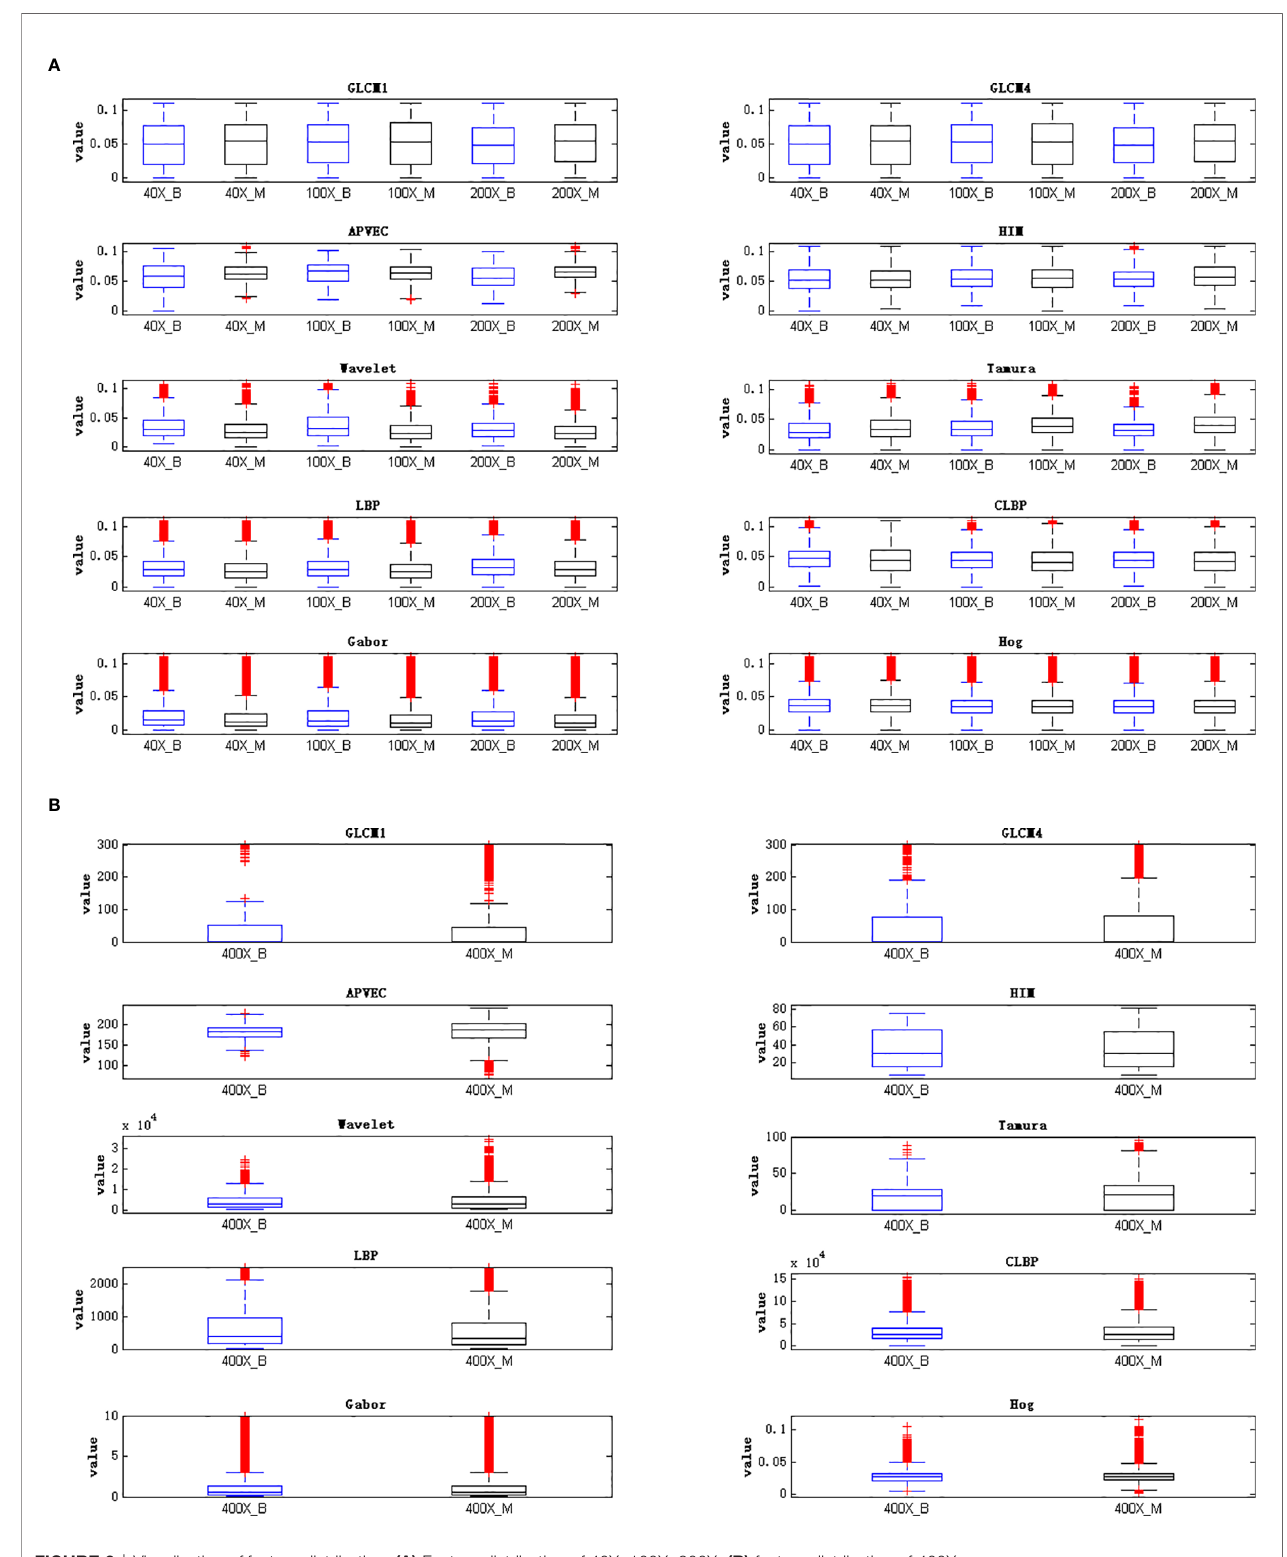
FIGURE 3 | Visualization of feature distribution. (A) Feature distribution of 40X, 100X, 200X, (B) feature distribution of